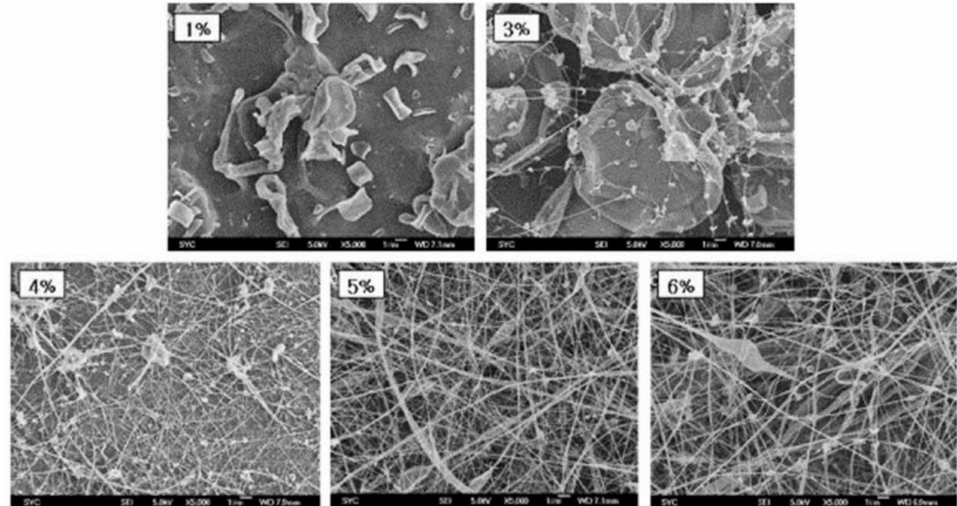
Figure 9. SEM images of chitin nanofibers with varying concentrations (concentrations are embedded in the images) [138]. Reproduced with permission from ref. [138]. Copyright Elsevier,